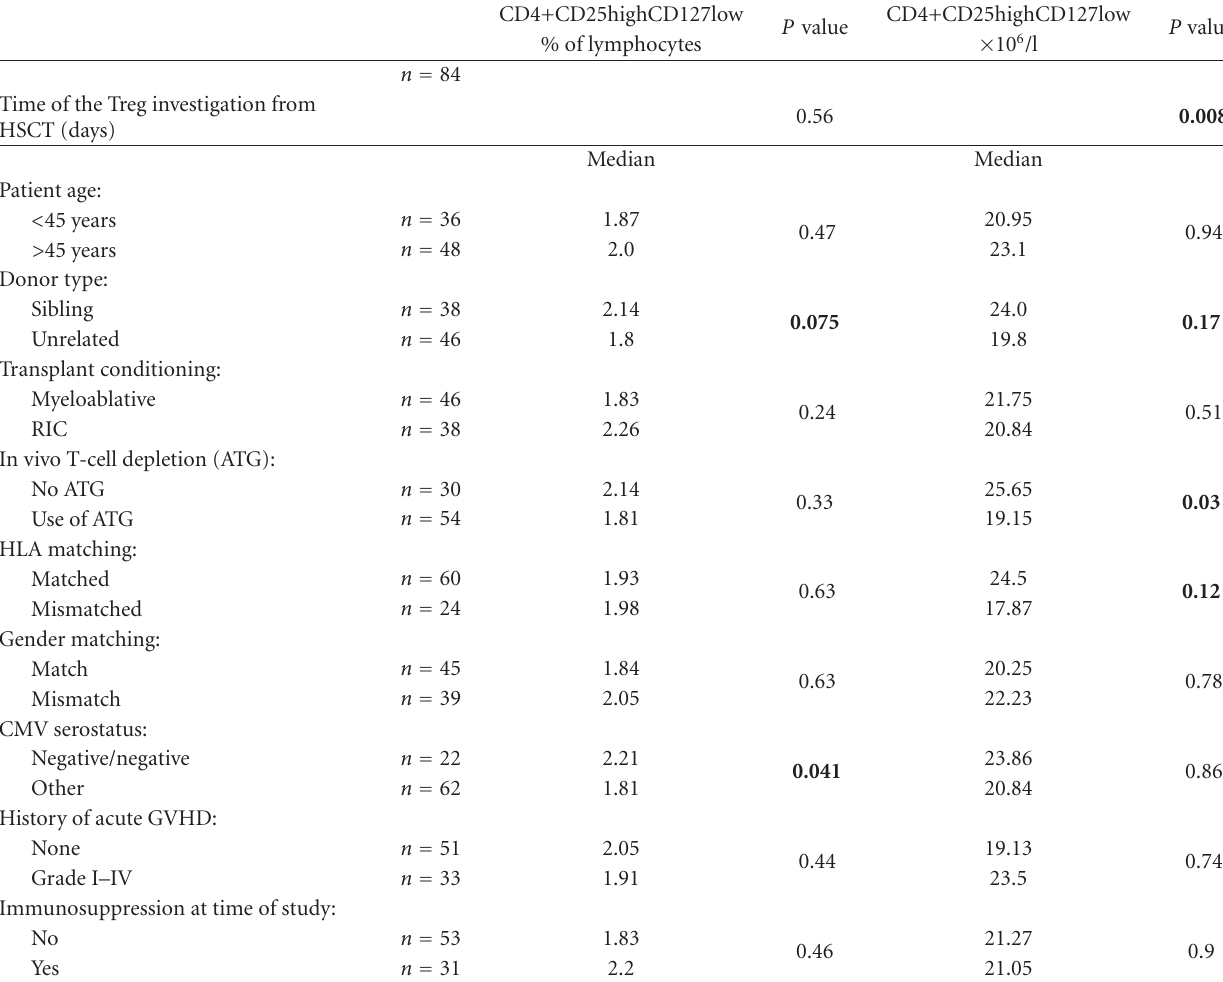
Table 2: Univariate analysis of factors with impact on the CD4+CD25highCD127low Treg frequencies and counts in 84 patients after allogeneic HSCT.